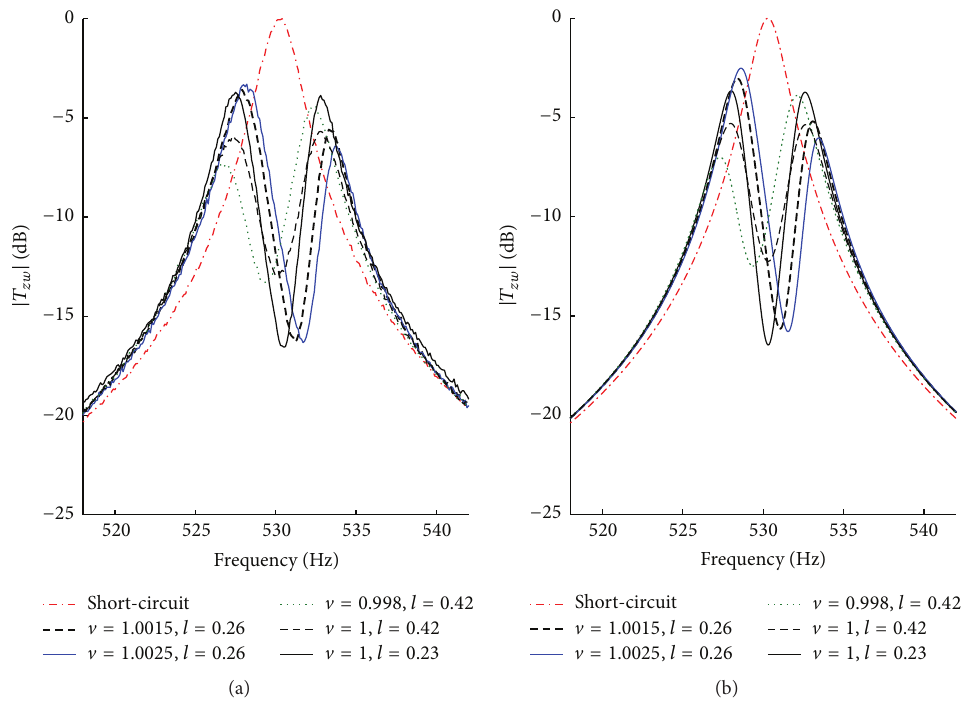
Figure 11: Experimental (a) and numerical (b) FRFs for the plate ( 𝑘 𝑛 = 0.0081).